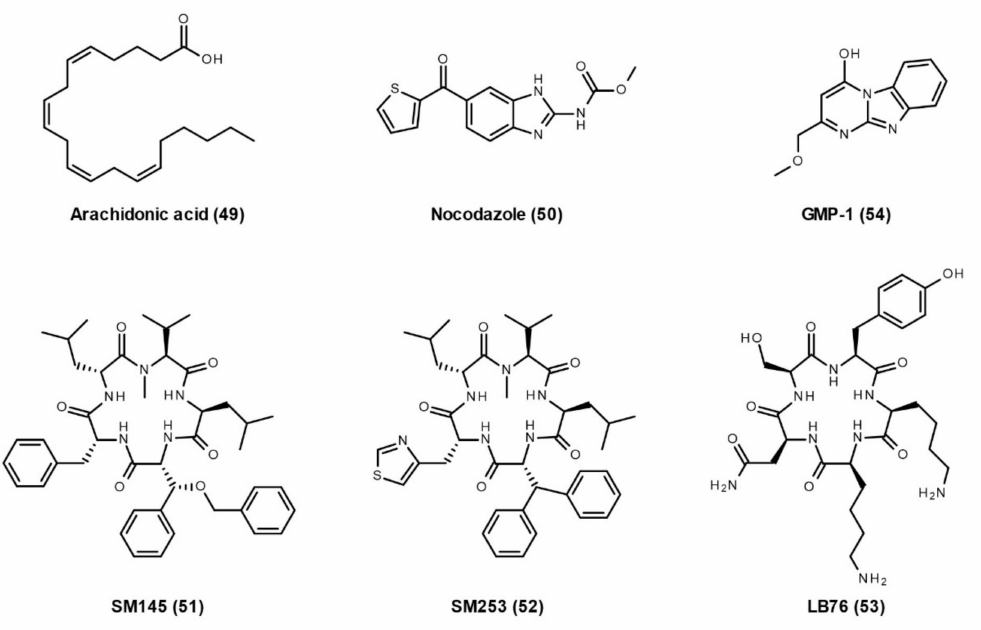
Figure 9. Developed small molecules with the ability to disrupt interactions between Hsp90 and TPR co-chaperones. Hsp90/Hsp70 Interaction with Dicarboxylate Clamp TPR (dcTPR)